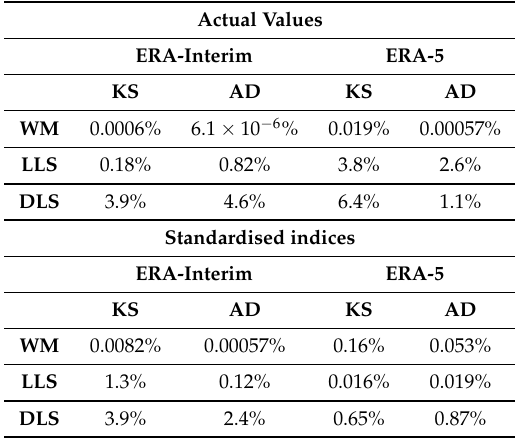
Table 3. Estimated p -values of the KS and AD two-sample homogeneity tests considering the distributions of the variables WM, LLS, and DLS (both actual values and standardized indices) at time-steps TS1 and TS4, for both the ERA-Interim and the ERA-5 datasets. Actual